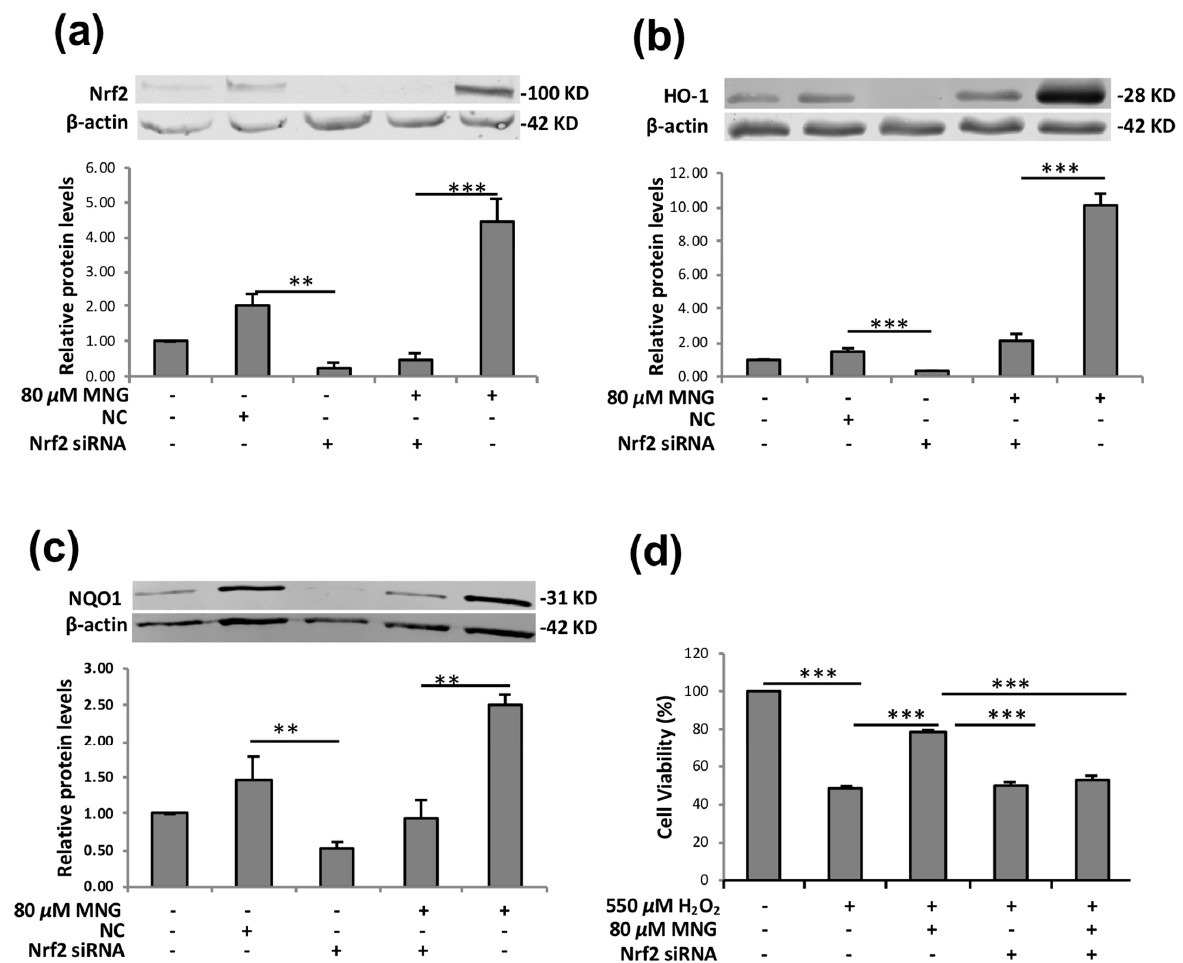
Figure 7. Nrf2 silencing attenuated MNG-mediated cytoprotective effect and induction of HO-1 and NQO1. ( a – c ) The cells were transfected with Nrf2 siRNA or NC siRNA, then incubated with or without 80 µ M MNG for 24 h, protein expression levels of Nrf2, HO-1 and NQO1 were detected by Western blot. ( d ) Nrf2 silencing reduced the cytoprotective effects of 80 μ M MNG on H 2 O 2 -induced cell damage. The cells were transfected with Nrf2 siRNA or NC siRNA, then incubated with or without 80 μ M MNG for 24 h, followed by 550 μ M H 2 O 2 for a further 6 h. All data in the figure are presented as means ± SEM of 3 independent experiments. * p < 0.05, ** p < 0.01, *** p < 0.001 compared to the indicated group.